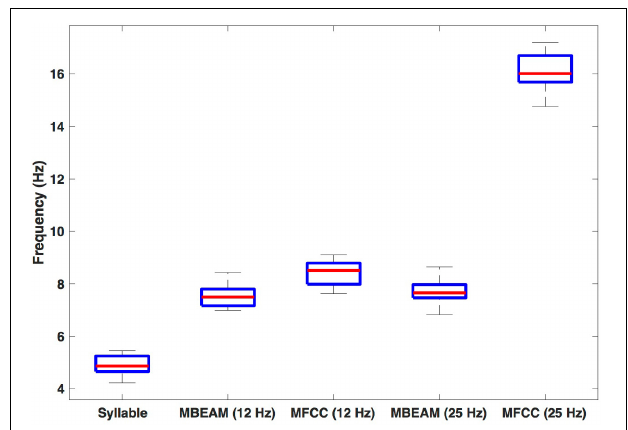
FIGURE 4 | Box plots of estimated frequencies of: syllables, MBEAM pulses, and MFCC pulses, for 12 and 25 Hz filter conditions. Each speaker contributes a single value to each